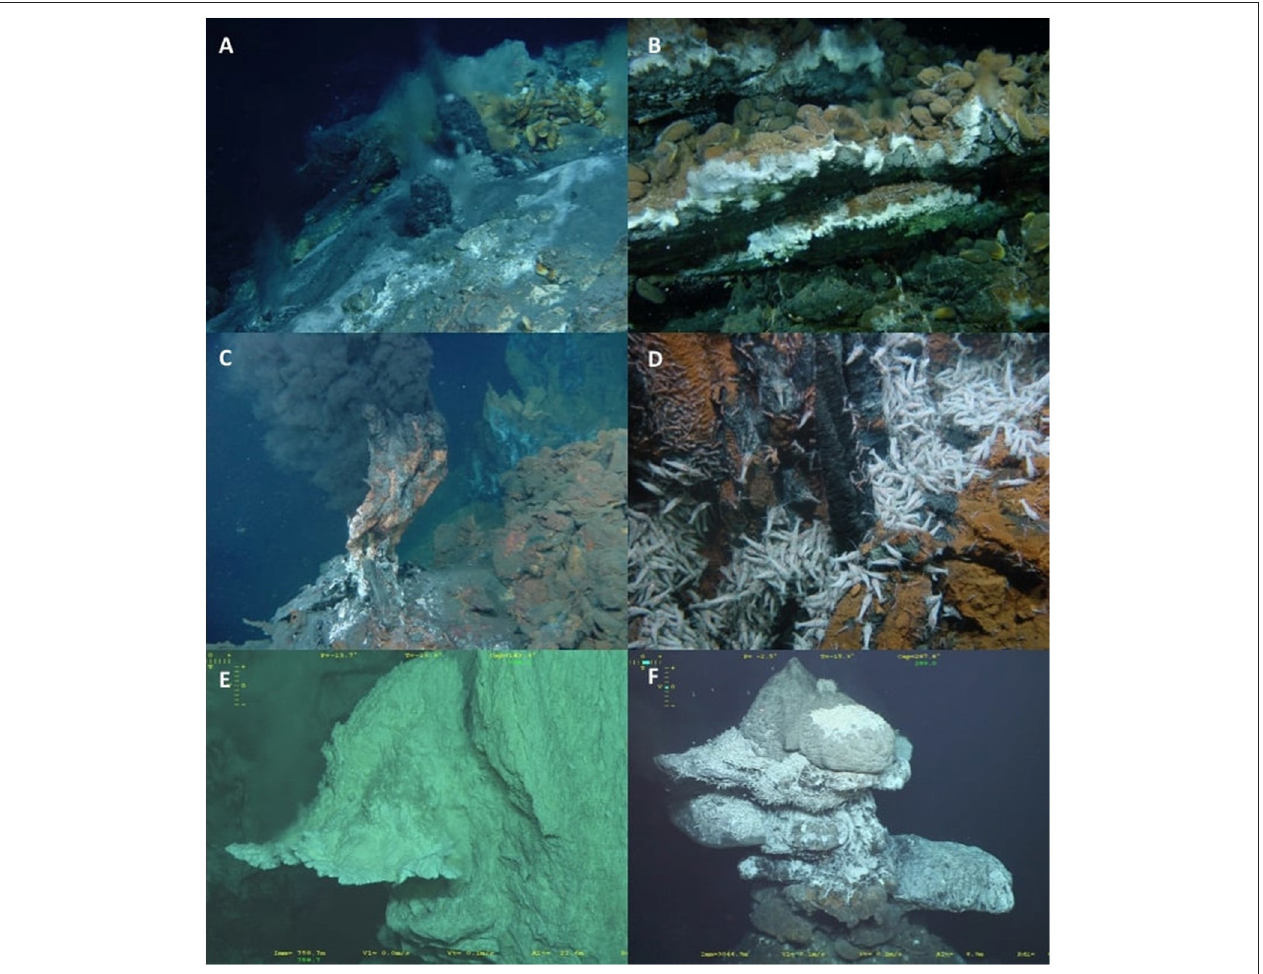
FIGURE 4 | (A) Menez Gwen hydrothermal vent field; (B) Lucky Strike hydrothermal vent field with Bathymodiolus azoricus mussel beds; (C,D) Rainbow vent field with swarms of the vent shrimp Rimicaris exoculata ; (E) Carbonate chimney flange at Lost City vent field; (F) Chimney at the Broken Spur vent field with swarms of R. exoculata . Images (A–D) reproduced with permission: © SEAHMA – PDCTM/MAR/15281/1999. Images (E,F) reproduced with permission: © Ifremer – Mission Transect (Le Bris,